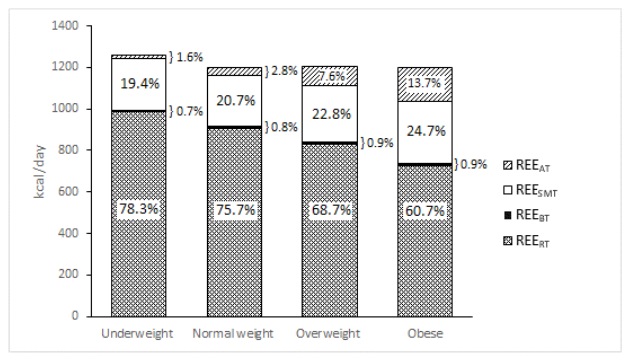
Figure 1. Total daily values (kcal/day) and relative (%) estimated resting energy expenditure based on DXA among boys classified according to nutritional